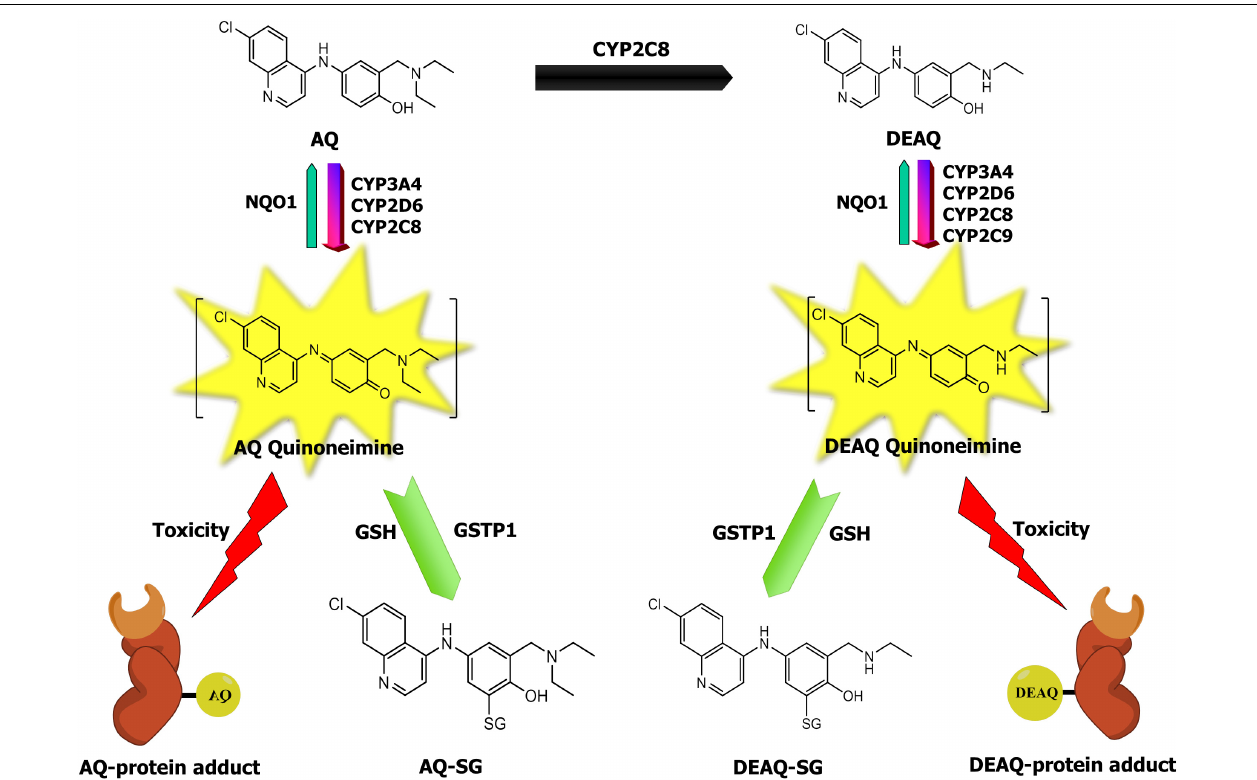
FIGURE 1 | The relationship between AQ metabolism and toxicity. AQ to its major metabolite DEAQ is predominantly catalyzed by CYP2C8 and forms DEAQ (Li et al., 2002). AQ and DEAQ are bioactivated to their corresponding reactive quinoneimine (QI), catalyzed by CYP3A4, CYP2D6, CYP2C8, and CYP2C9 (Zhang et al., 2017b). Protein-reactive QIs of AQ and DEAQ can bind to cellular proteins and subsequently lead to toxicity (Harrison et al., 1992; Naisbitt et al., 1998). Reactive QIs can be detoxified by conjugation reaction with glutathione, which is catalyzed by GSTs, and by reduction reaction catalyzed by human NQO1 (Zhang et al., 2017a).